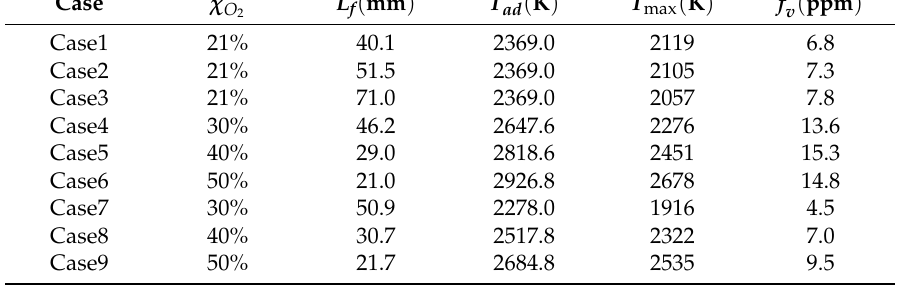
Table 2. Maximum temperatures and soot volume fractions of the nine cases.